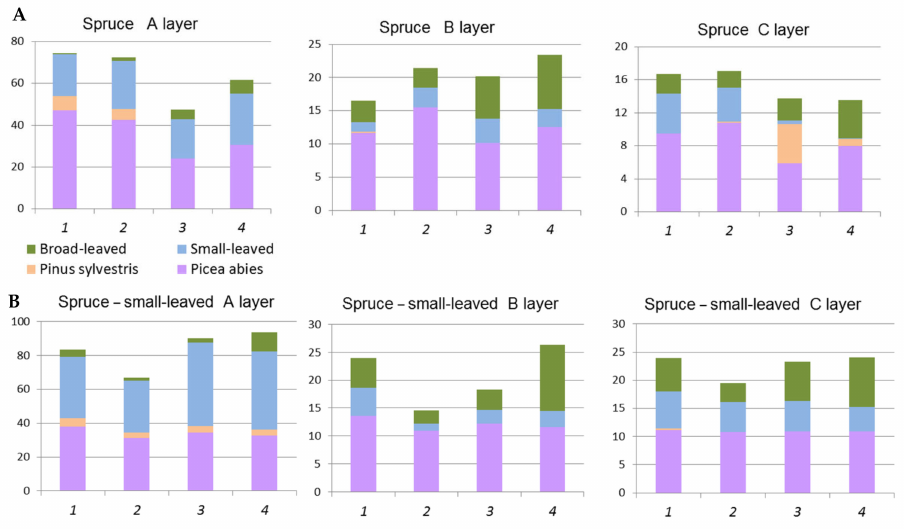
Figure 4. Changes in the activity of tree species in different layers of Spruce ( A ) and Spruce–small-leaved communities ( B ). Association groups: 1—DshShG; 2—Sh; 3—ShBh; 4—Bh. X axis—number of association groups, Y axis—activity.